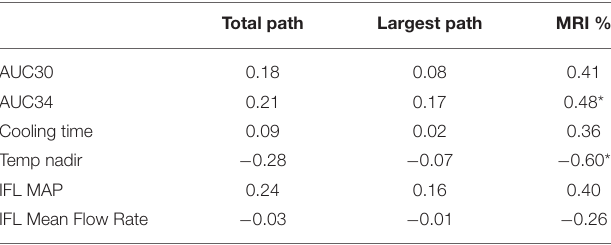
TABLE 3 | Pearson correlations between cooling parameters and outcomes on 17 hypothermia treated animals.